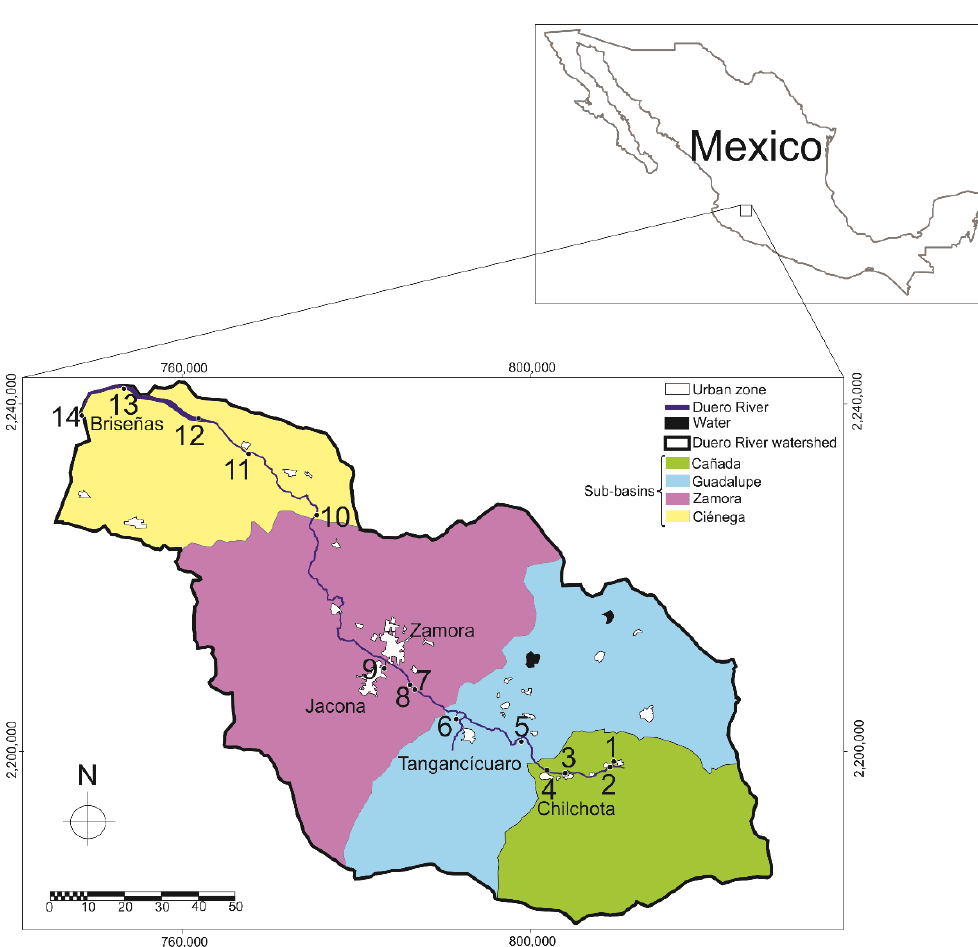
Figure 1. Duero River watershed with the location of the sub basins and sampling sites: (1) Kunio, (2) Tacuro, (3) La Toma, (4) El Rastro (5) Etúcuaro, (6) Camécuaro, (7) Antes Central de Abastos, (8) Después Central de Abastos, (9) Verduzco, (10) Estanzuela, (11) San Cristóbal, (12) Capulín, (13) Cumuato, and (14) Ibarra.